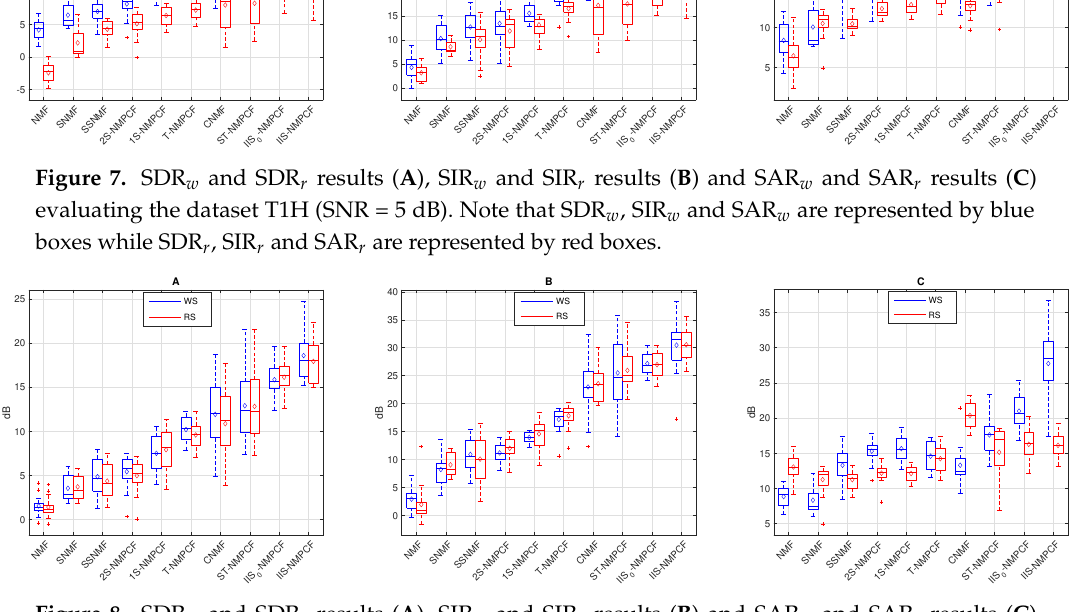
Figure 8. SDR w and SDR r results ( A ), SIR w and SIR r results ( B ) and SAR w and SAR r results ( C ) evaluating the dataset T1M (SNR = 0 dB). Note that SDR w , SIR w and SAR w are represented by blue boxes while SDR r , SIR r and SAR r are represented by red